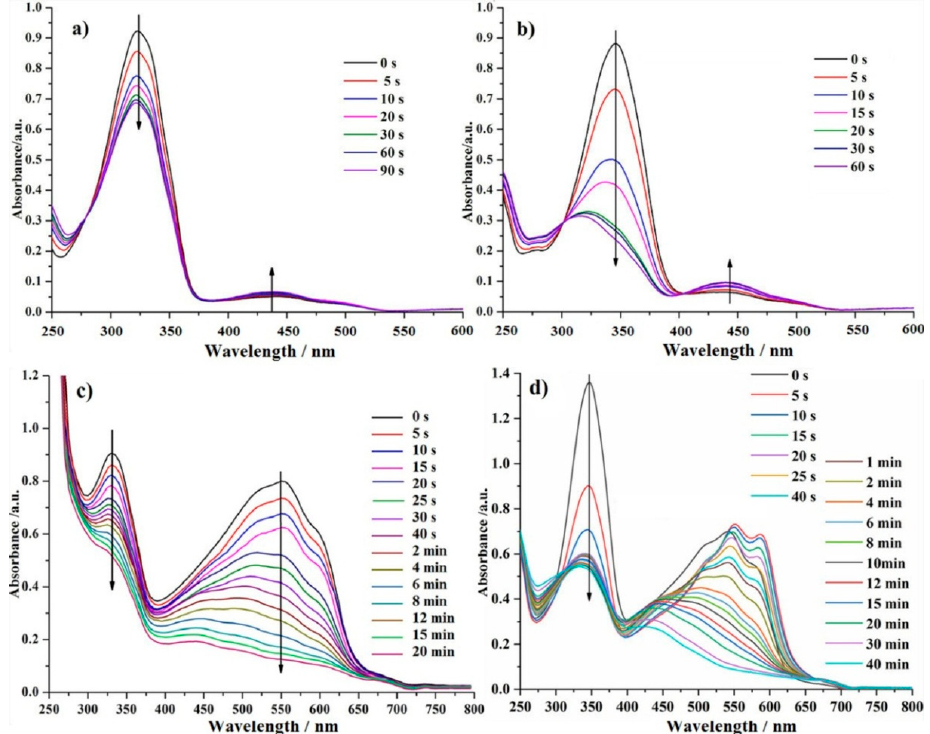
Figure 4. UV–Vis spectra changes for the diluted azobenzene (AB)-incorporated ( a ) M1 , ( b ) M2 , ( c ) double-stranded P1 , and ( d ) single-stranded P2 solutions under UV light irradiation.